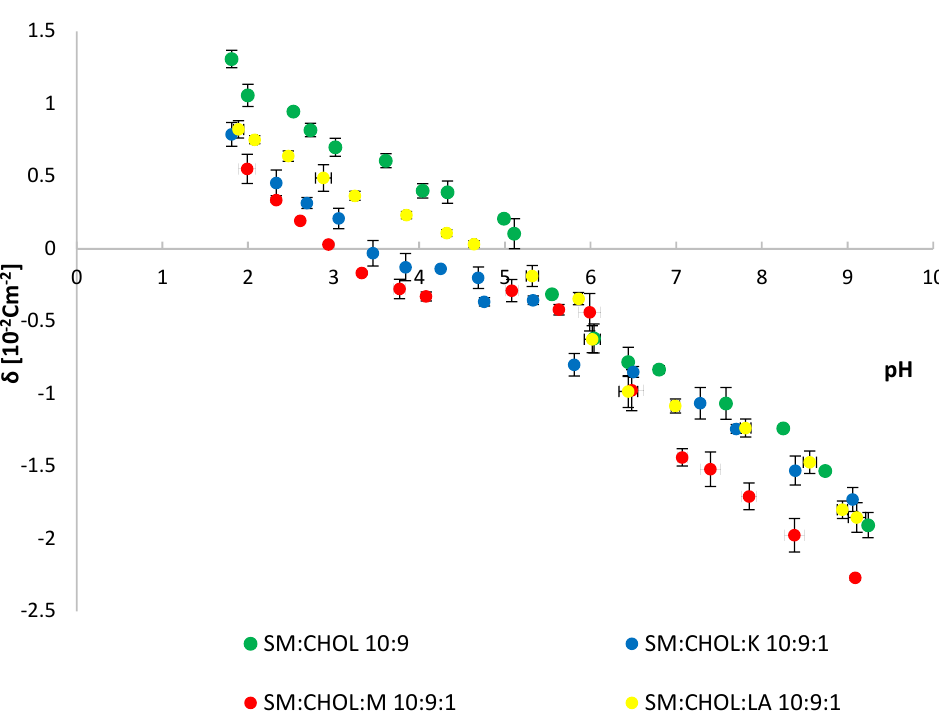
Figure 8. Membrane surface charge densities vs. the pH of the electrolyte solution for (SM:CHOL), (SM:CHOL:K), (SM:CHOL:M) and (SM:CHOL:LA) systems. Table 2. Surface charge densities and isoelectric points for (DPPC:CHOL), (DPPC:CHOL:K),